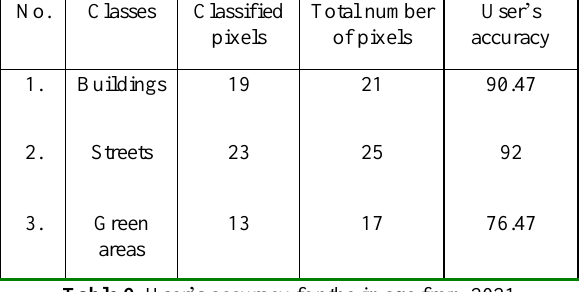
Table 9 . User’s accuracy for the image from 2021 No.